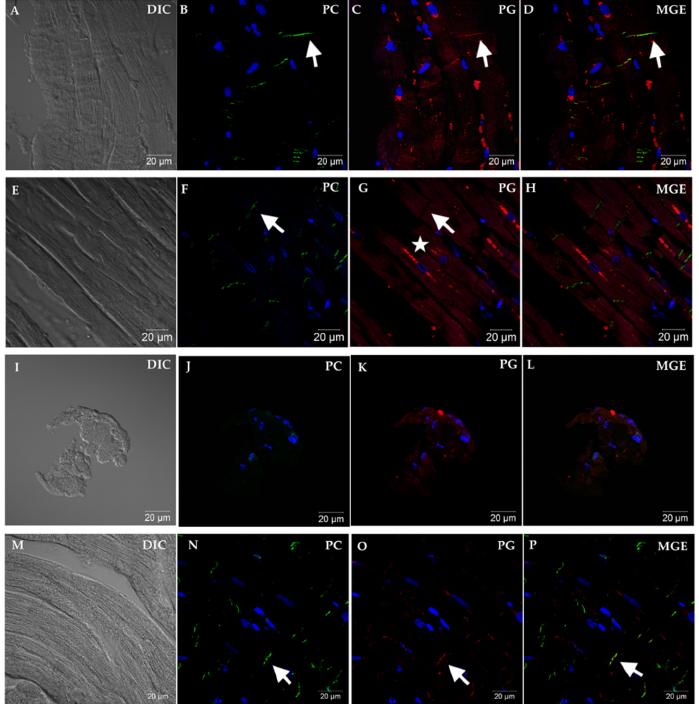
Figure 2. Representative immunofluorescent images showing PC and PG cellular localization from EMB sections of four different dogs. Panels ( A – D ) represent non-ARVC cardiac disease in a Dogue de Bordeaux (Dog #25) diagnosed with viral myocarditis. Note the longitudinal orientation of fibers ( A ), and positive immunofluorescent signal for PC at the area representing the ID ( B ). Immunofluorescent signal for PG ( C ) is also localized to the area of the ID and merges with PC signal ( D ). Panels ( E – H ) represent advanced (clinical) ARVC in an English bulldog (Dog #43). Note that while PC remains localized to the area of the ID (arrow, ( F )), a complete absence of PG is noted in this area (arrow, ( G )). Instead, PG is localized in a perinuclear pattern (star) and does not colocalize with PC ( H ). Panels ( I – L ) represent a non-diagnostic sample from a Great Dane (Dog #17) with tachycardia-induced cardiomyopathy. Panel I reveals the small number and imperfect orientation of cells, and lack of obvious cardiomyocytes, as evidenced in the non-diagnostic samples. Absence of PC signal was criteria for non-diagnostic sample ( J ). Panels ( M – P ) show representative images from a non-clinical boxer (Dog #44) with moderate ventricular ectopic load. Merged (MGE, ( D , H , L , P )) shows colocalization, when present, of PC with PG (arrows). Images were obtained at 63× magnification.